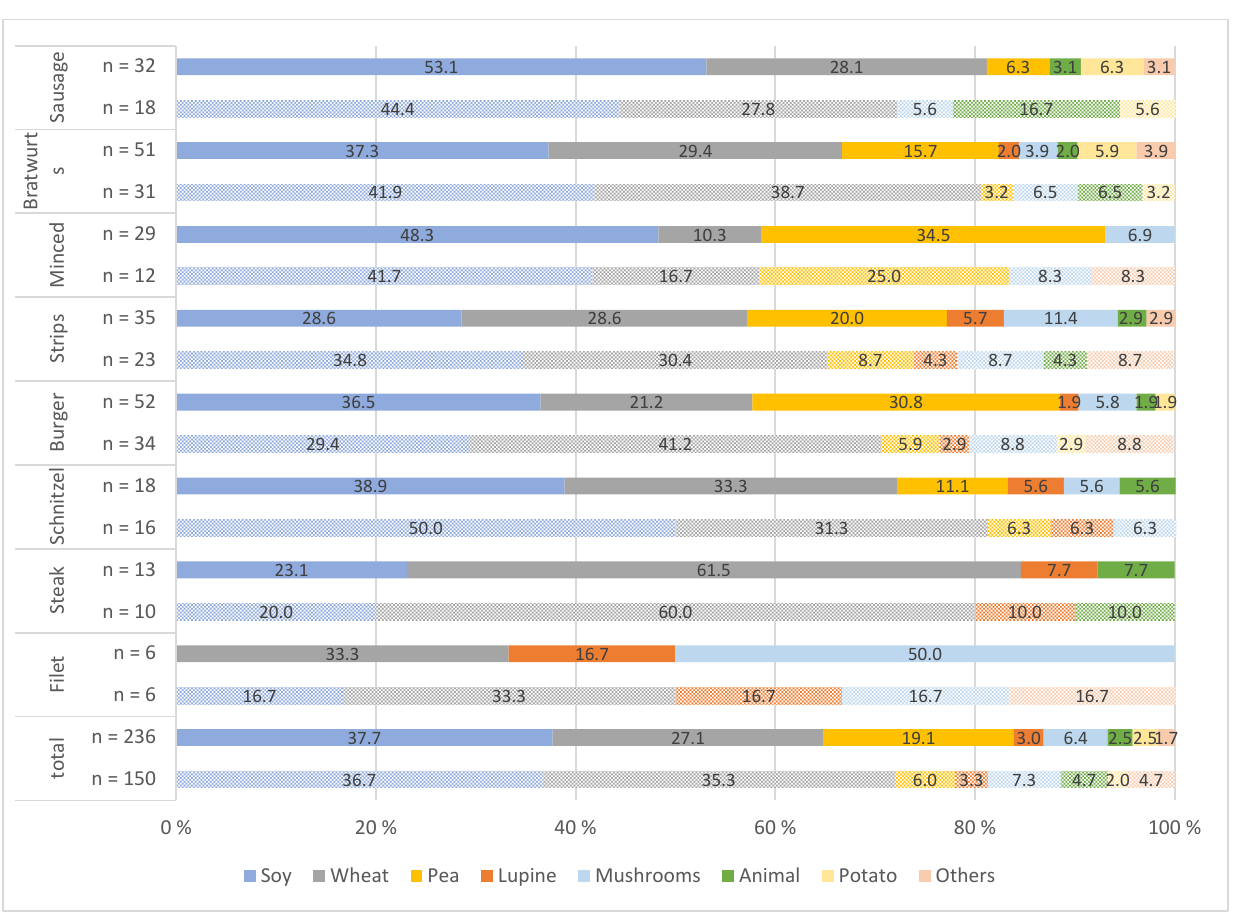
Figure 2. Protein sources used in plant-based meat alternatives (PBMA-cold) in 2019 (patterned color) and 2021 (solid color) (%); n = number of products; animal = milk and/or egg protein; others = millet, sunflower seeds.